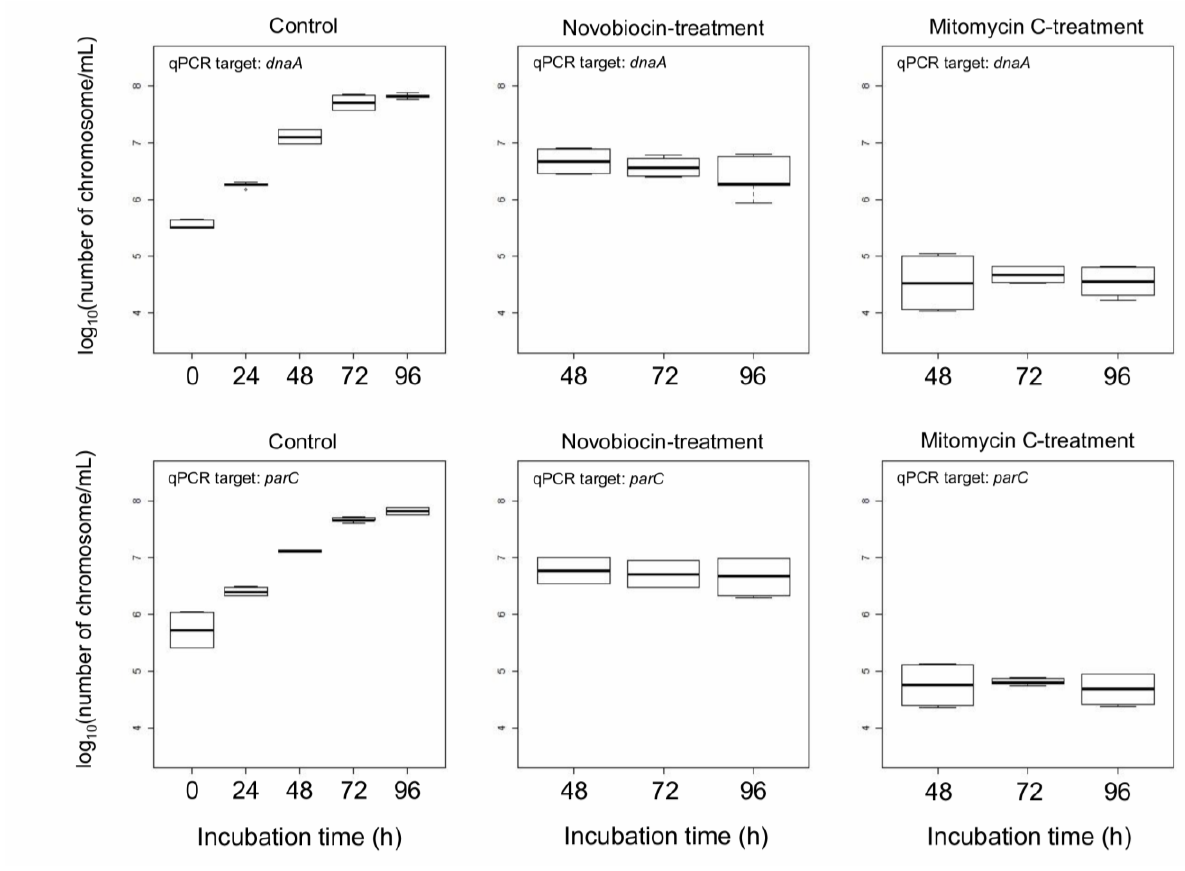
FIGURE 2: Boxplot of DNA concentration of E. facalis protoplasts. Control protoplasts were not treated by any DNA replication inhibitors. Mitomycin C or novobiocin was added at 24 h of incubation. After that, mitomycin C- and novobiocin-treated protoplasts were used at